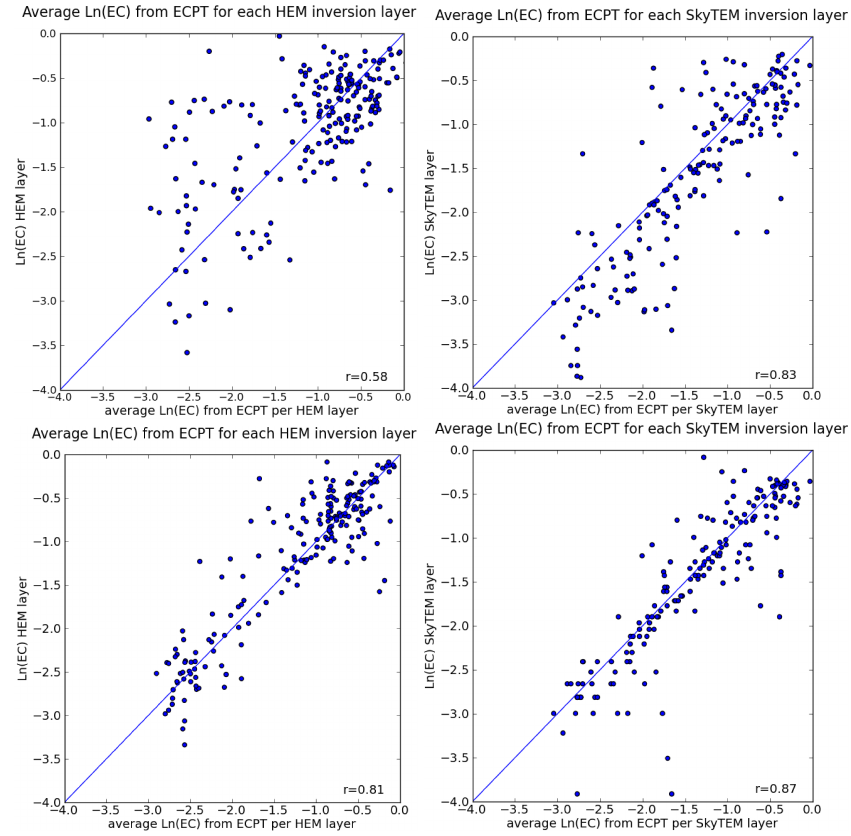
Fig. 8. (a) Comparison between Ln(EC) of airborne models (HEM and SkyTEM) and average Ln(EC) from corresponding interval in the ECPT. Maximum distance between airborne EM model and ECPT is 50m. (b) Comparison between Ln(EC) of airborne models (HEM and SkyTEM), using a-priori ECPT data, and average Ln(EC) from corresponding interval in the ECPT. Maximum distance between EM model and ECPT is 50m.